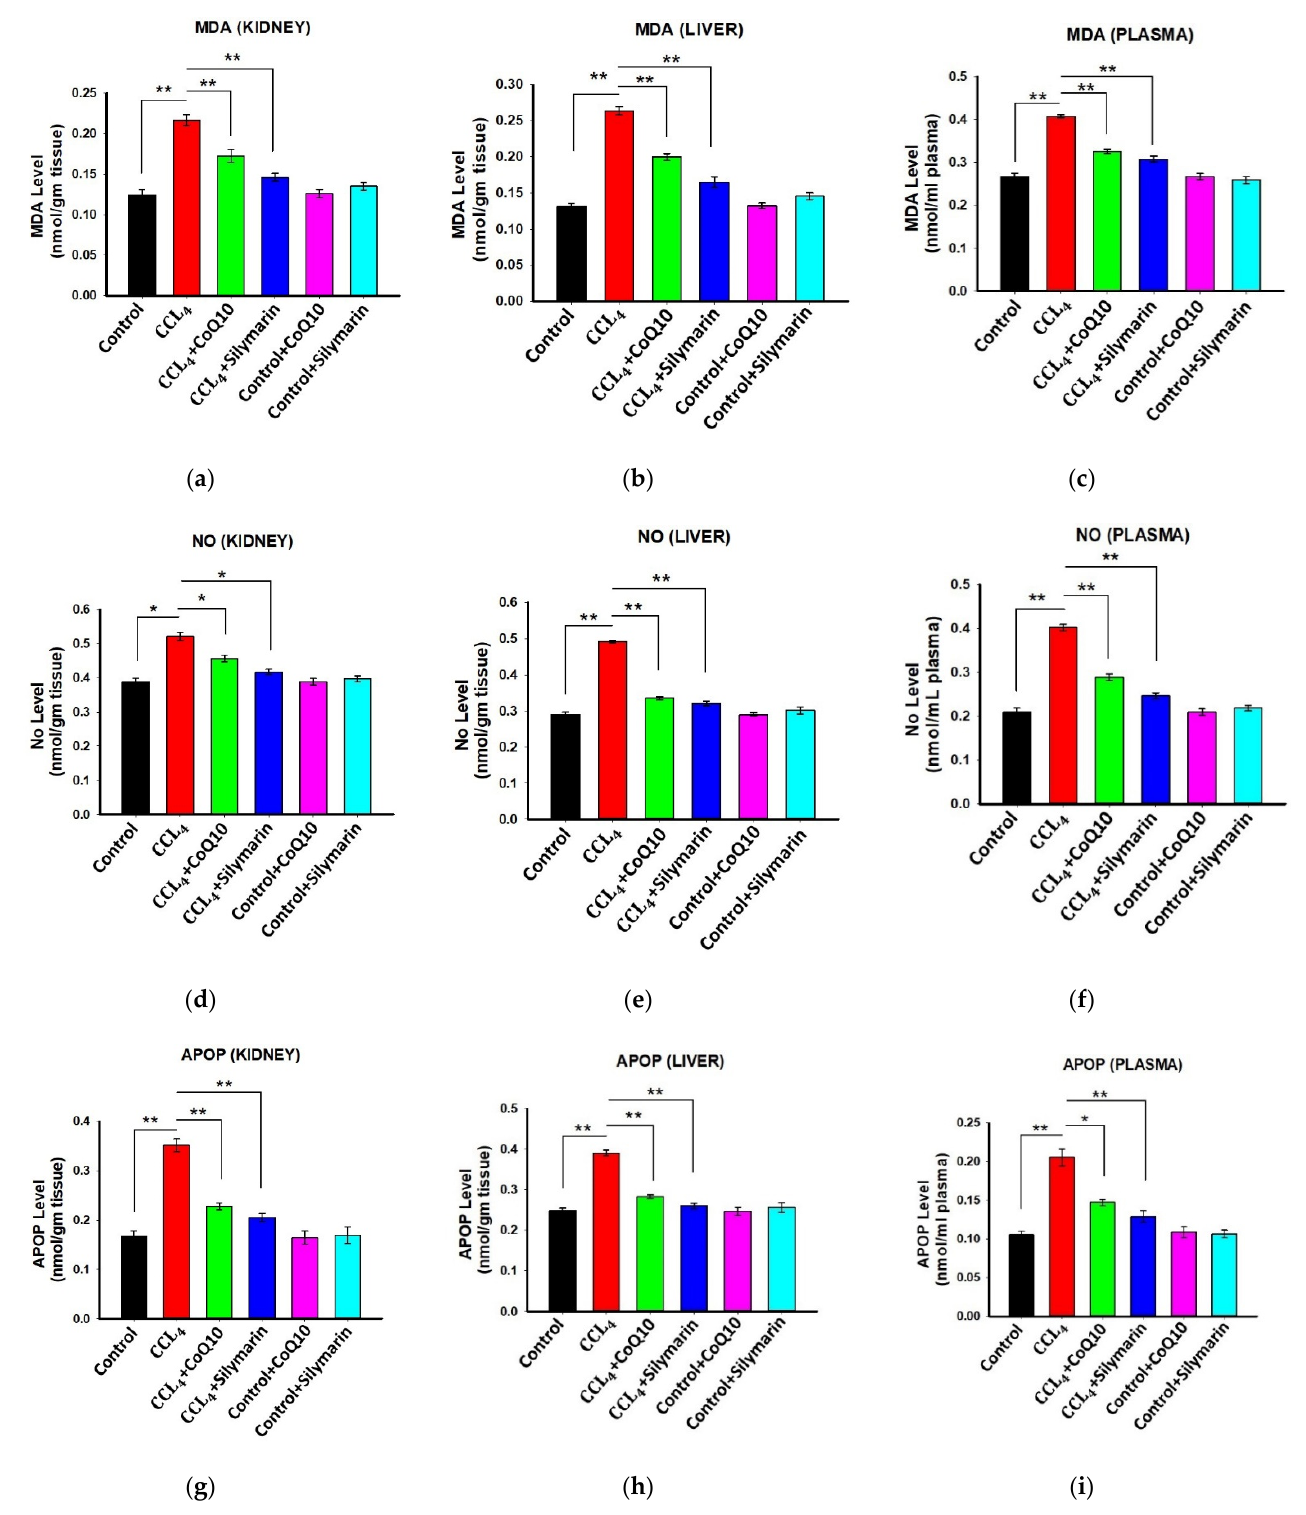
Figure 2. Effect of CoQ10 and silymarin on MDA ( a – c ), NO ( d – f ), and advanced protein oxidation product (APOP) ( g – i ) levels in kidney, liver, and plasma of ovariectomized female rats. Data are presented as mean ± SD, n = 6, where n = 6. Statistical analysis involved post-hoc tests. Statistical significance is indicated as * p ≤ 0.05 and ** p ≤